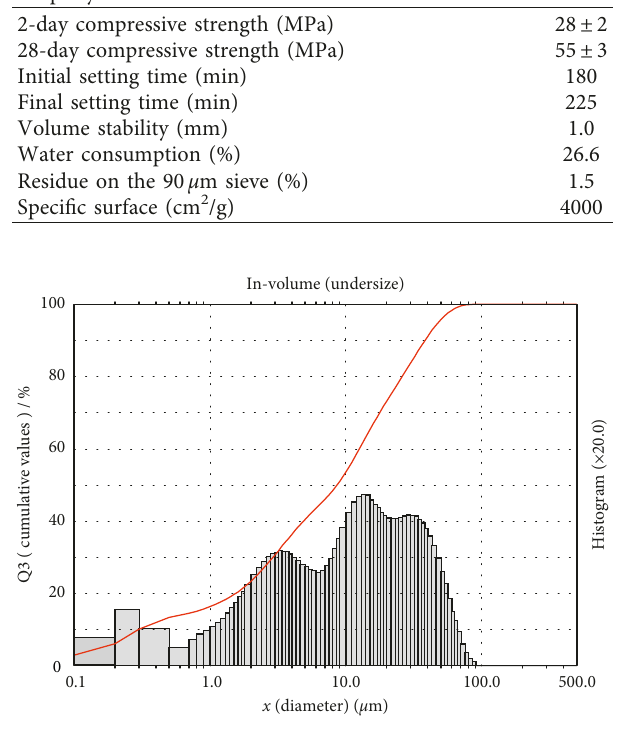
Figure 1: The particle size distribution of Portland cement without mineral